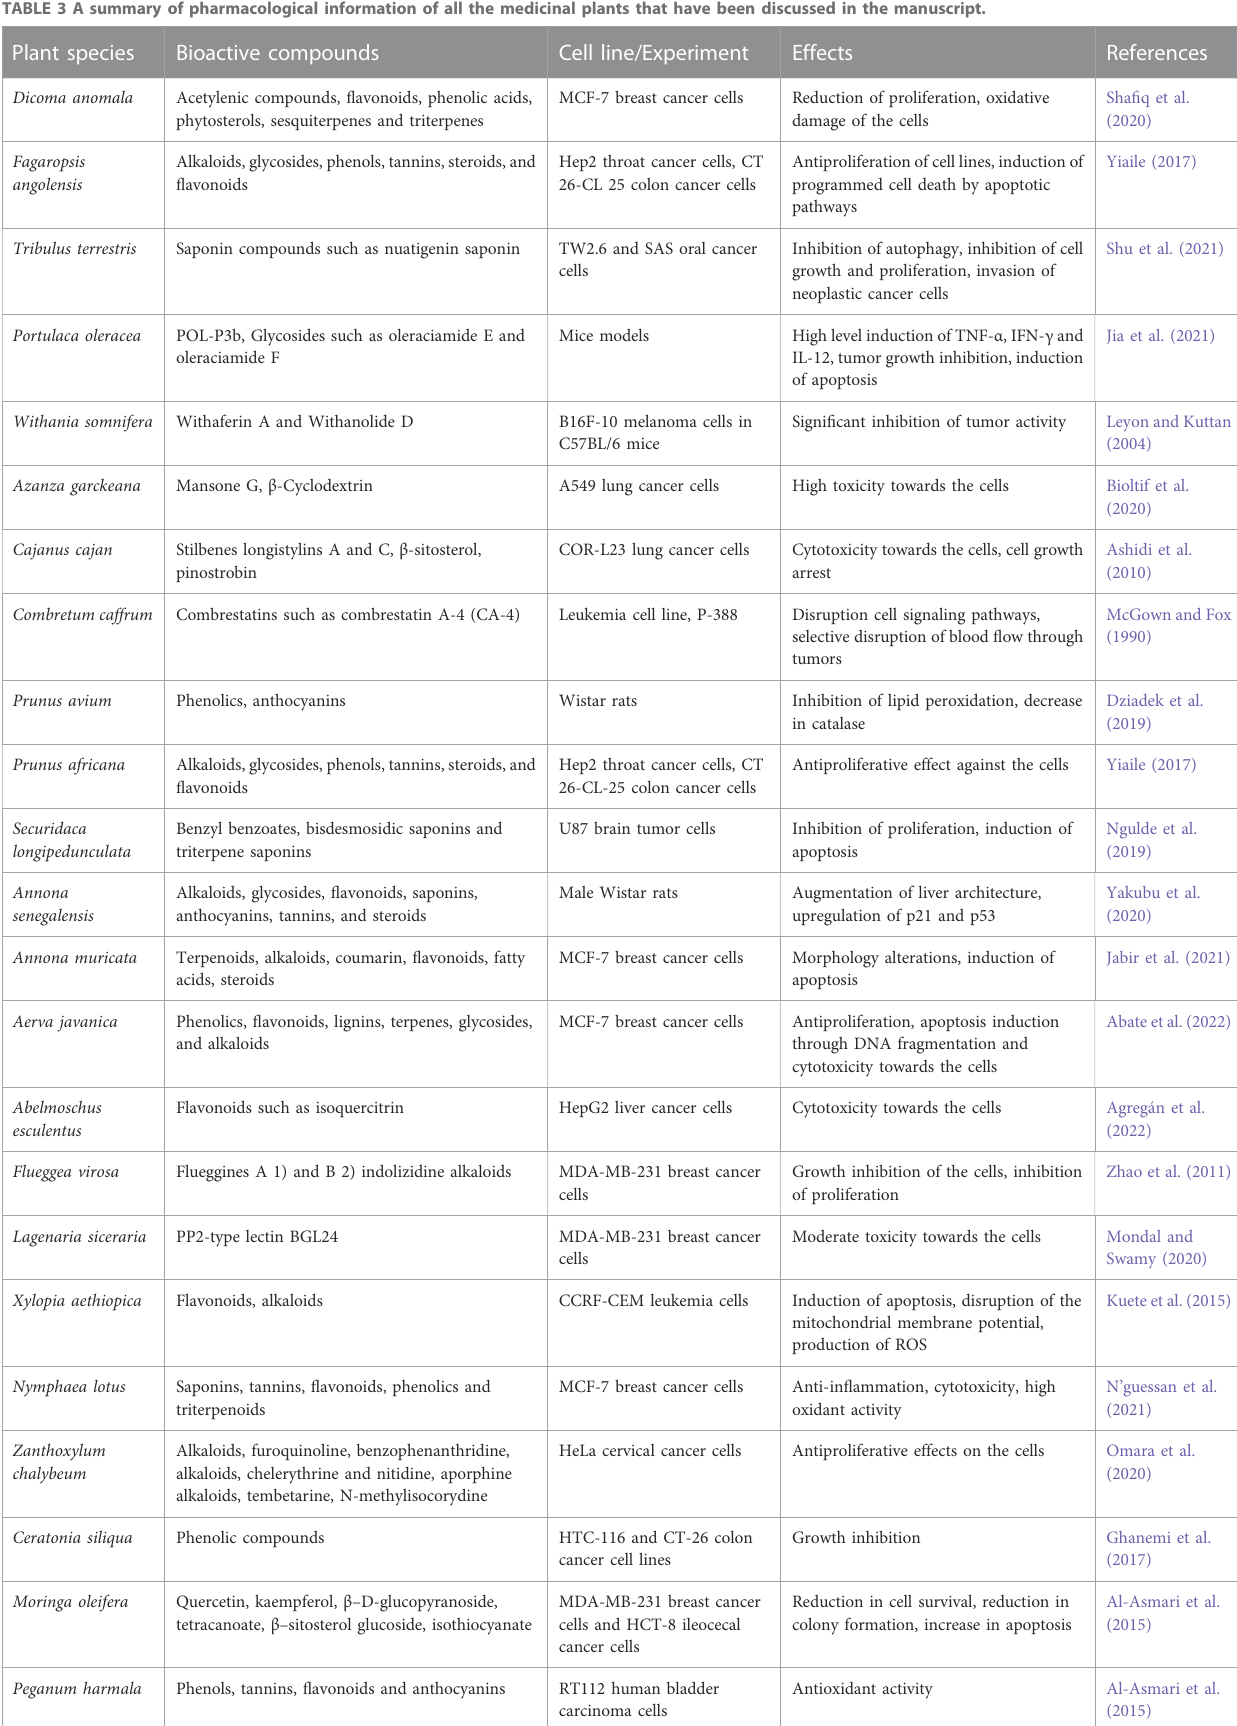
TABLE 3 A summary of pharmacological information of all the medicinal plants that have been discussed in the